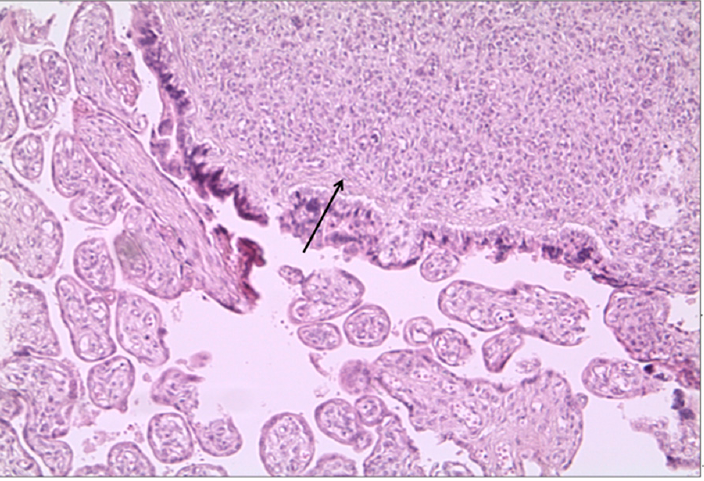
Figure 3. Placental chorioangioma in a woman with SARS-CoV-2 infection ( → ) (hematoxylin-and- eosin stain; original magnification 10×).